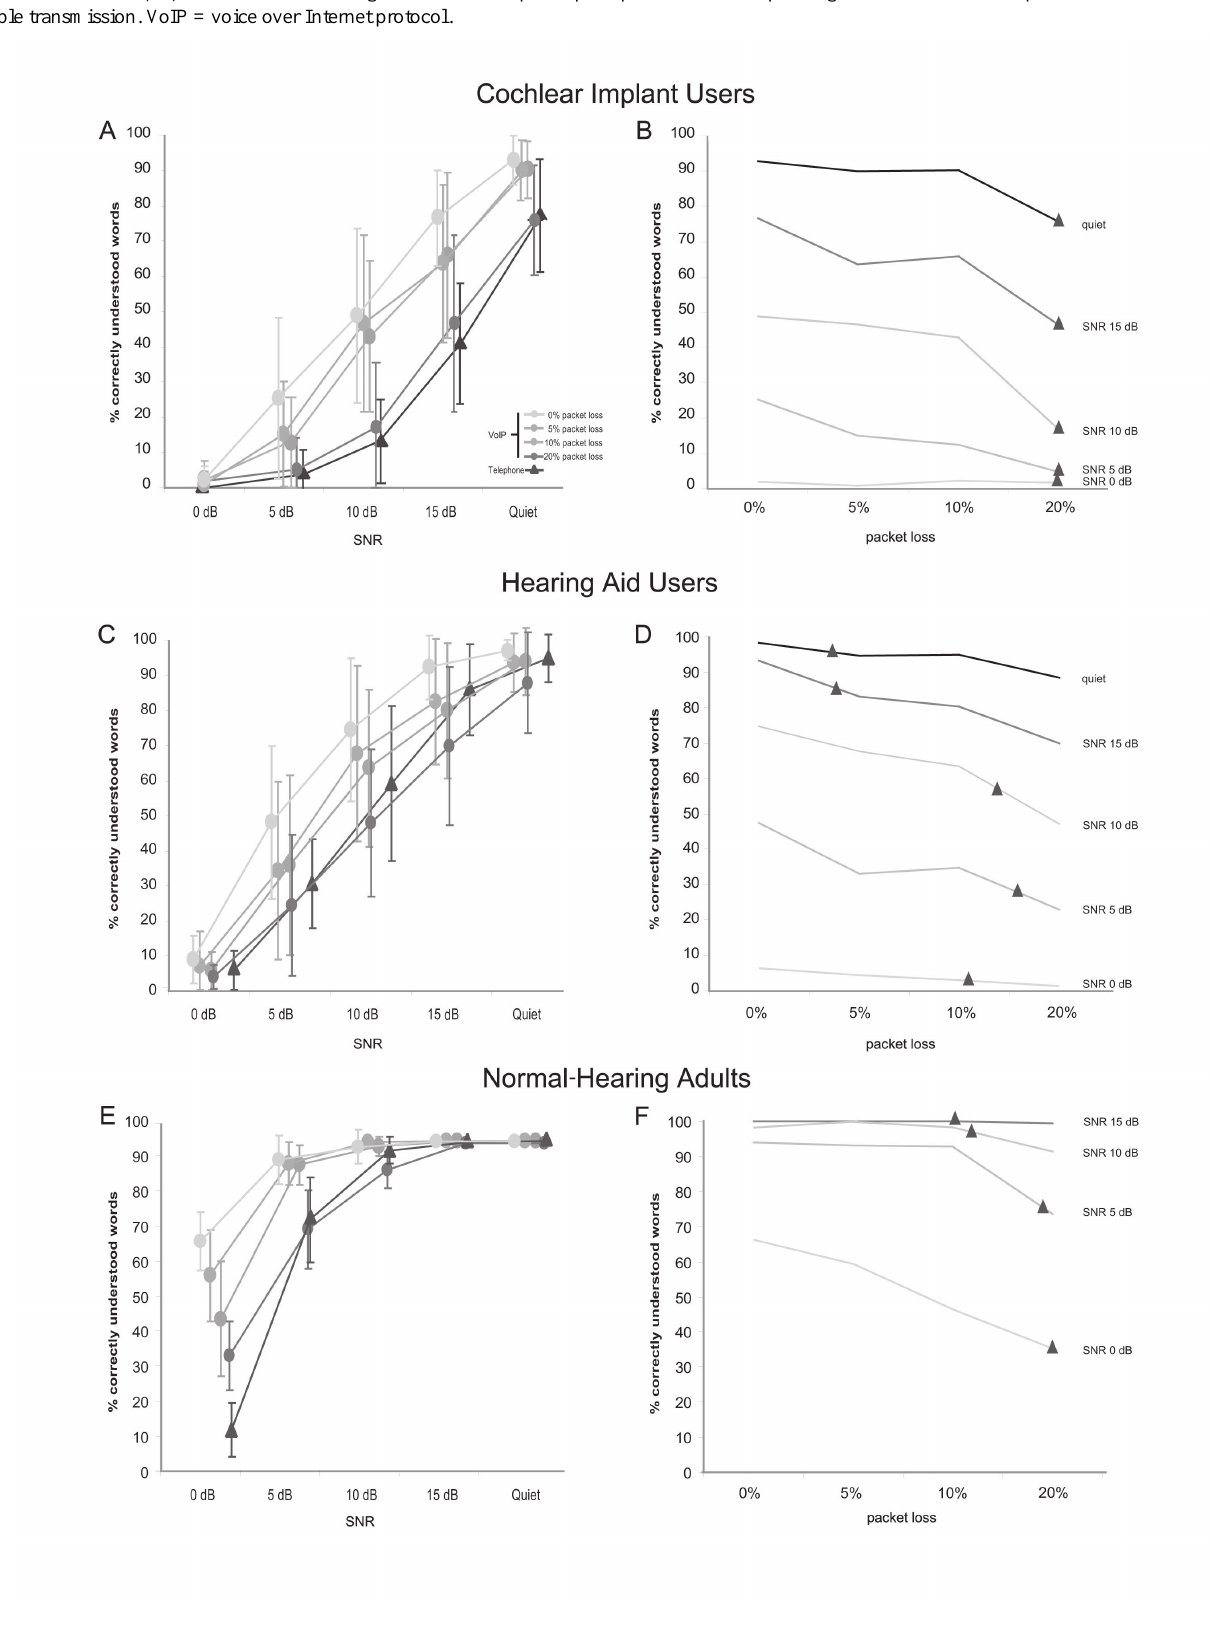
Figure 3. Speech perception scores assessed with the HSM Sentence Test are plotted against different signal to noise ratios (SNRs) for cochlear implant users (A), hearing aid users (C), and normal-hearing adults (E) for 4 different VoIP qualities (0%, 5%, 10%, and 20% packet loss) and 1 ideal conventional telephone quality. The impact of different network conditions with increasing data packet loss (x-axis) on word discrimination scores is shown for different SNRs in B, D, and F. The black triangle indicates the speech perception level corresponding to a conventional telephone with a constant and stable transmission. VoIP = voice over Internet